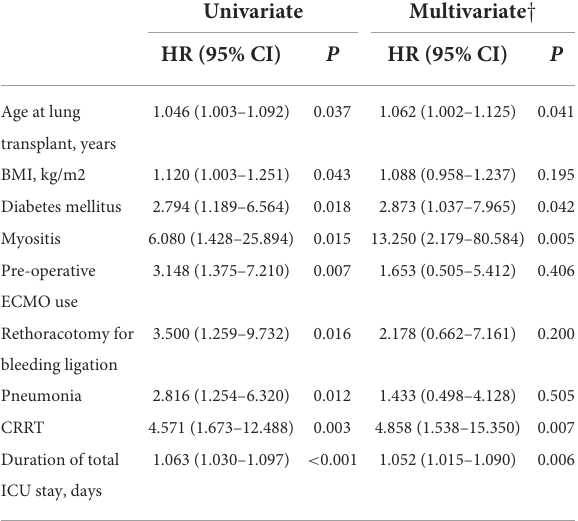
TABLE 5 Risk factors for symmetric leg weakness after lung